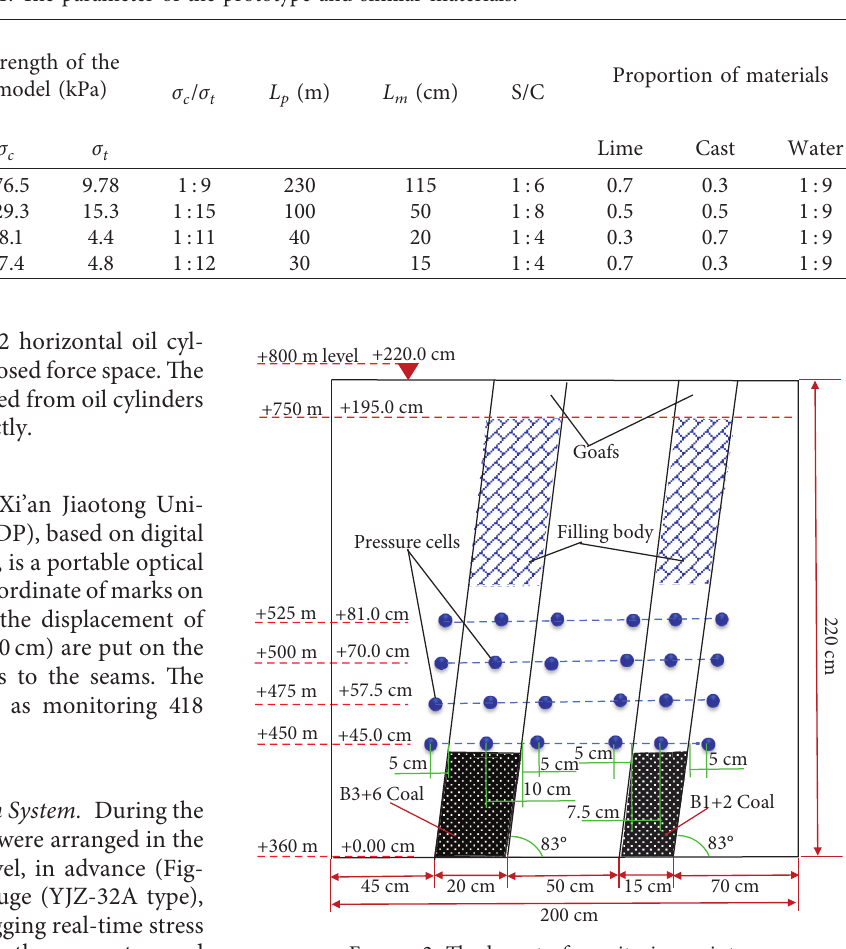
Table 1: The parameter of the prototype and similar materials.